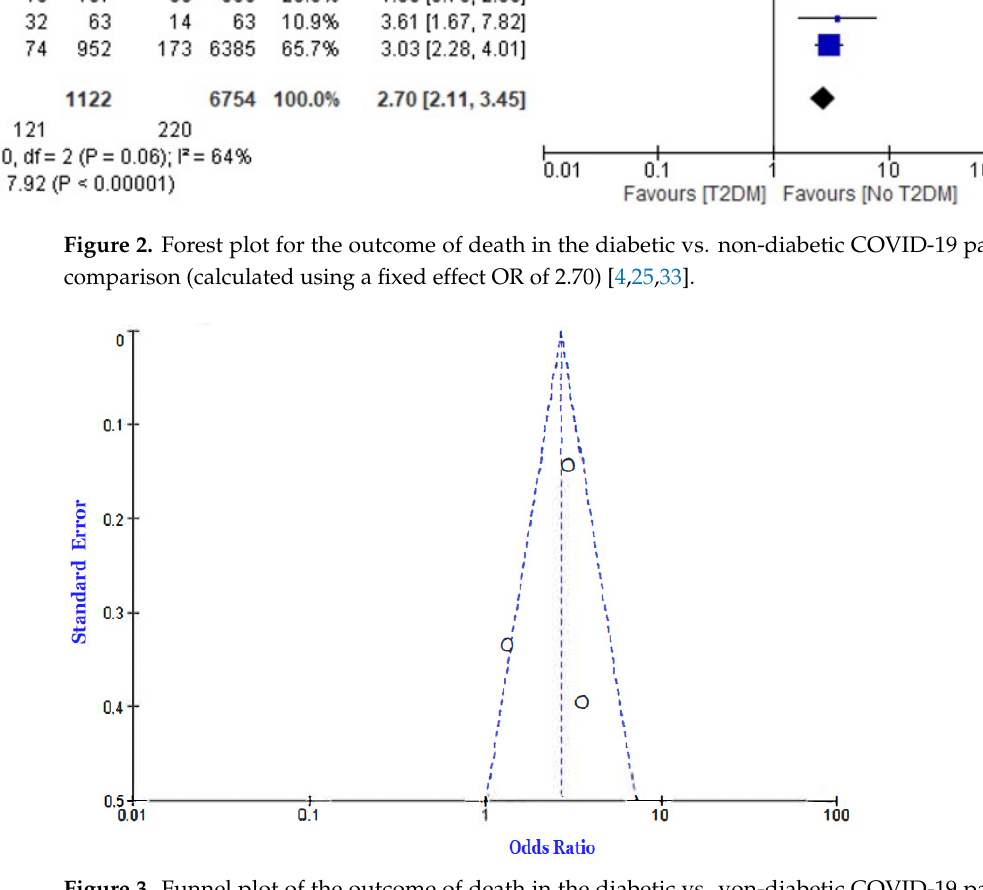
Figure 3. Funnel plot of the outcome of death in the diabetic vs. von-diabetic COVID-19 patients’ comparison [4,25,33]. Comparison 2: Well-controlled vs. Poorly Controlled Blood Sugar.